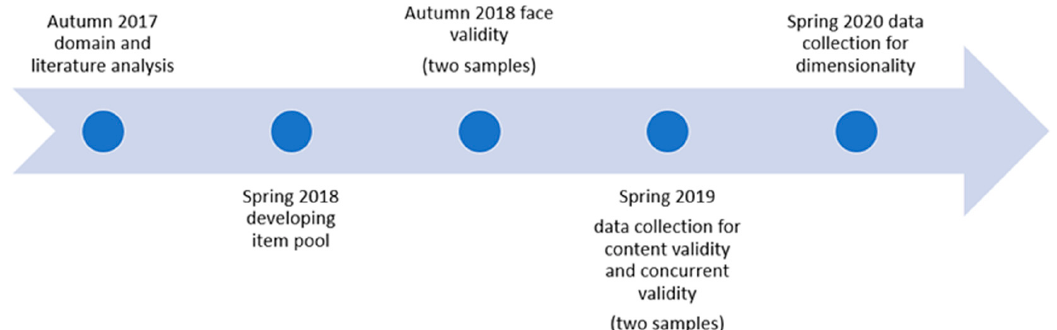
Figure 1. Overview of the scale development and validation processes.